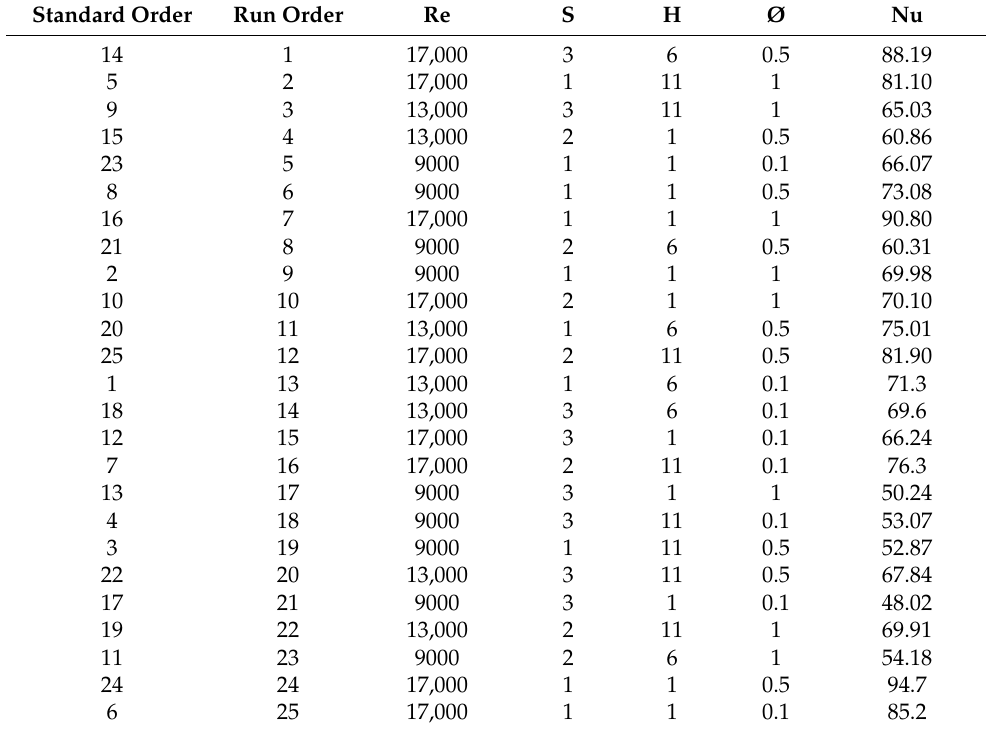
Table 2. The DOE plan of twin jets impingement heat